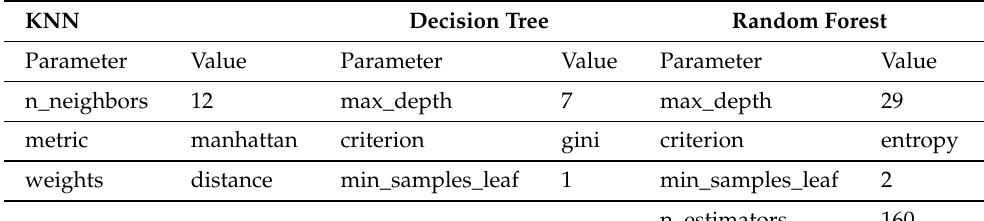
Table 2. hyper-parameter values- Part II. SVM SLP MLP LSTM Par.